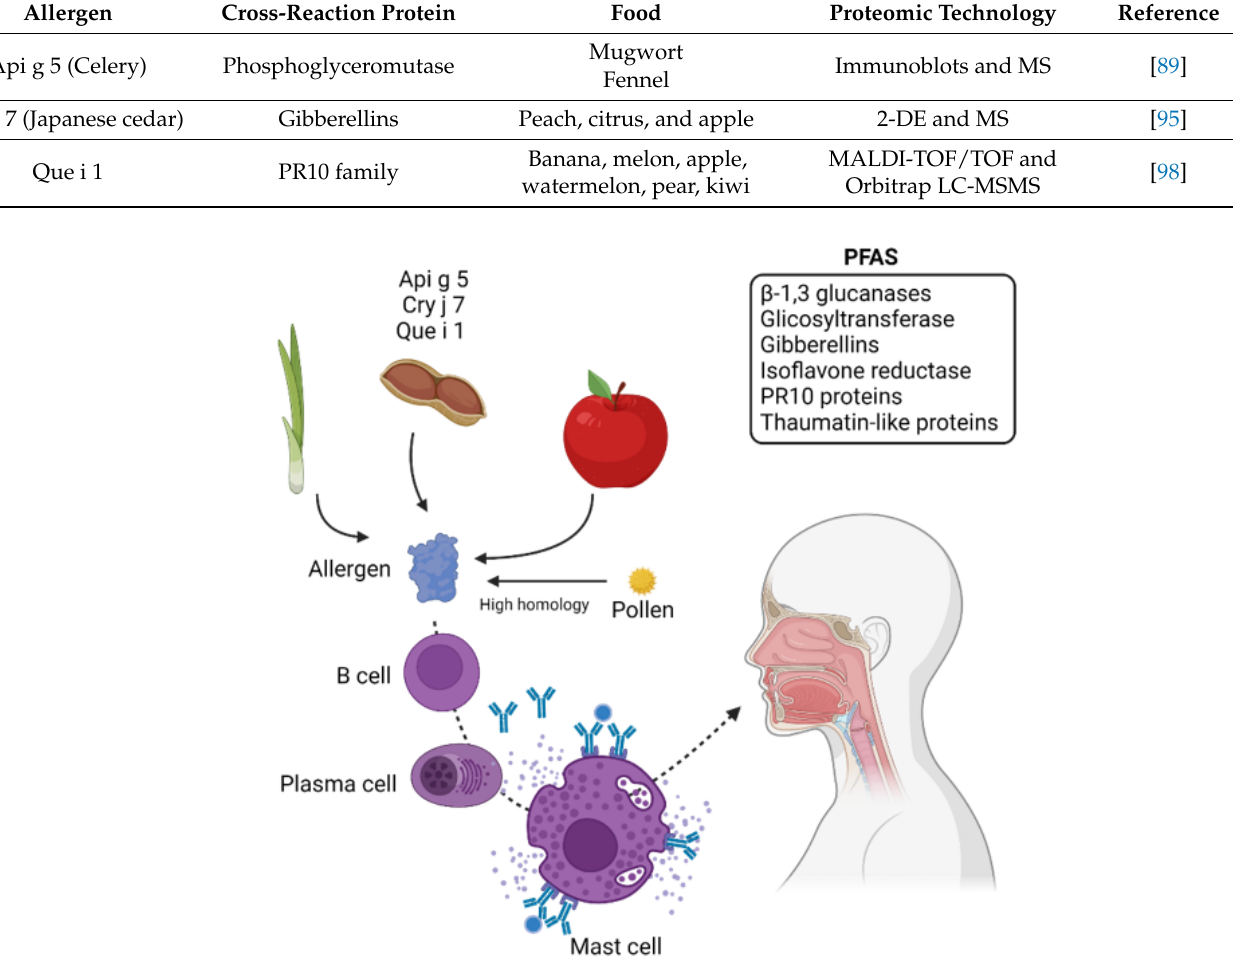
Figure 2. Potential proteins discovered in PFAS. PFAS causes allergies in people who are sensitized to pollen proteins. The high homology between allergy pollen proteins and proteins from food can cause cross-reaction, which is IgE-mediated. Allergens found in fruits and vegetables like Api g 5, Cry j 7, and Que i 1 and some proteins that can cause cross-reaction are also indicated. Gibberellins and PR10 proteins are common proteins that can cause cross-reactivity with some food allergens. Created with BioRender.com (accessed on 10 May 2022).